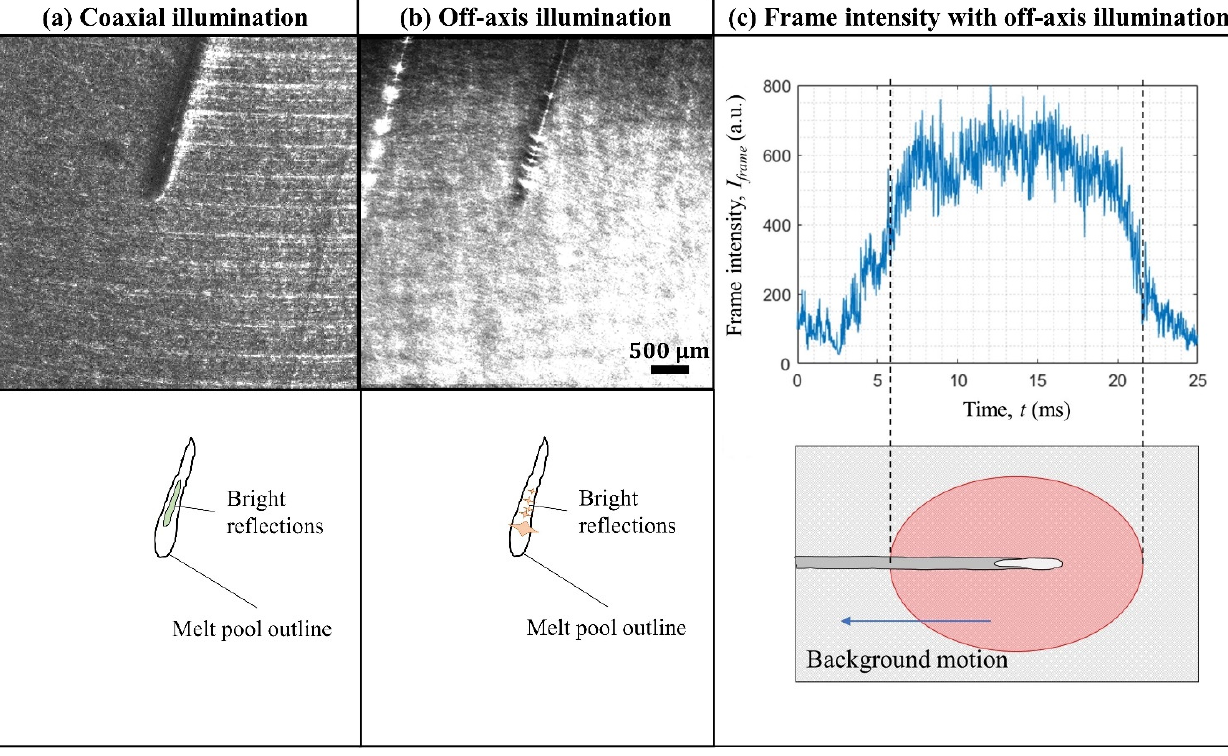
Figure 5. Representative frame and its schematic representation of the tests conducted ( a – c ) trend of the frame intensity for the videos with off-axis illumination and schematic representation of the condition tested.